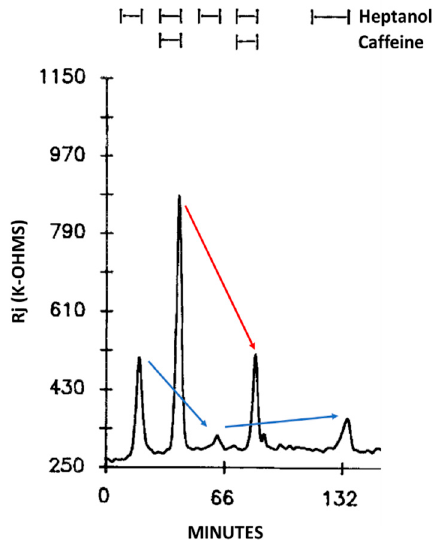
5 of 16 Figure 3. Time course of changes in electrotonic potentials ( A ) and Rj ( B ) in axons uncoupled with heptanol in the presence and absence of 20 mM caffeine. Addition of caffeine to heptanol causes a rapid change in the amplitude of the electrotonic potentials ( A ), indicative of rapid increase in Rj